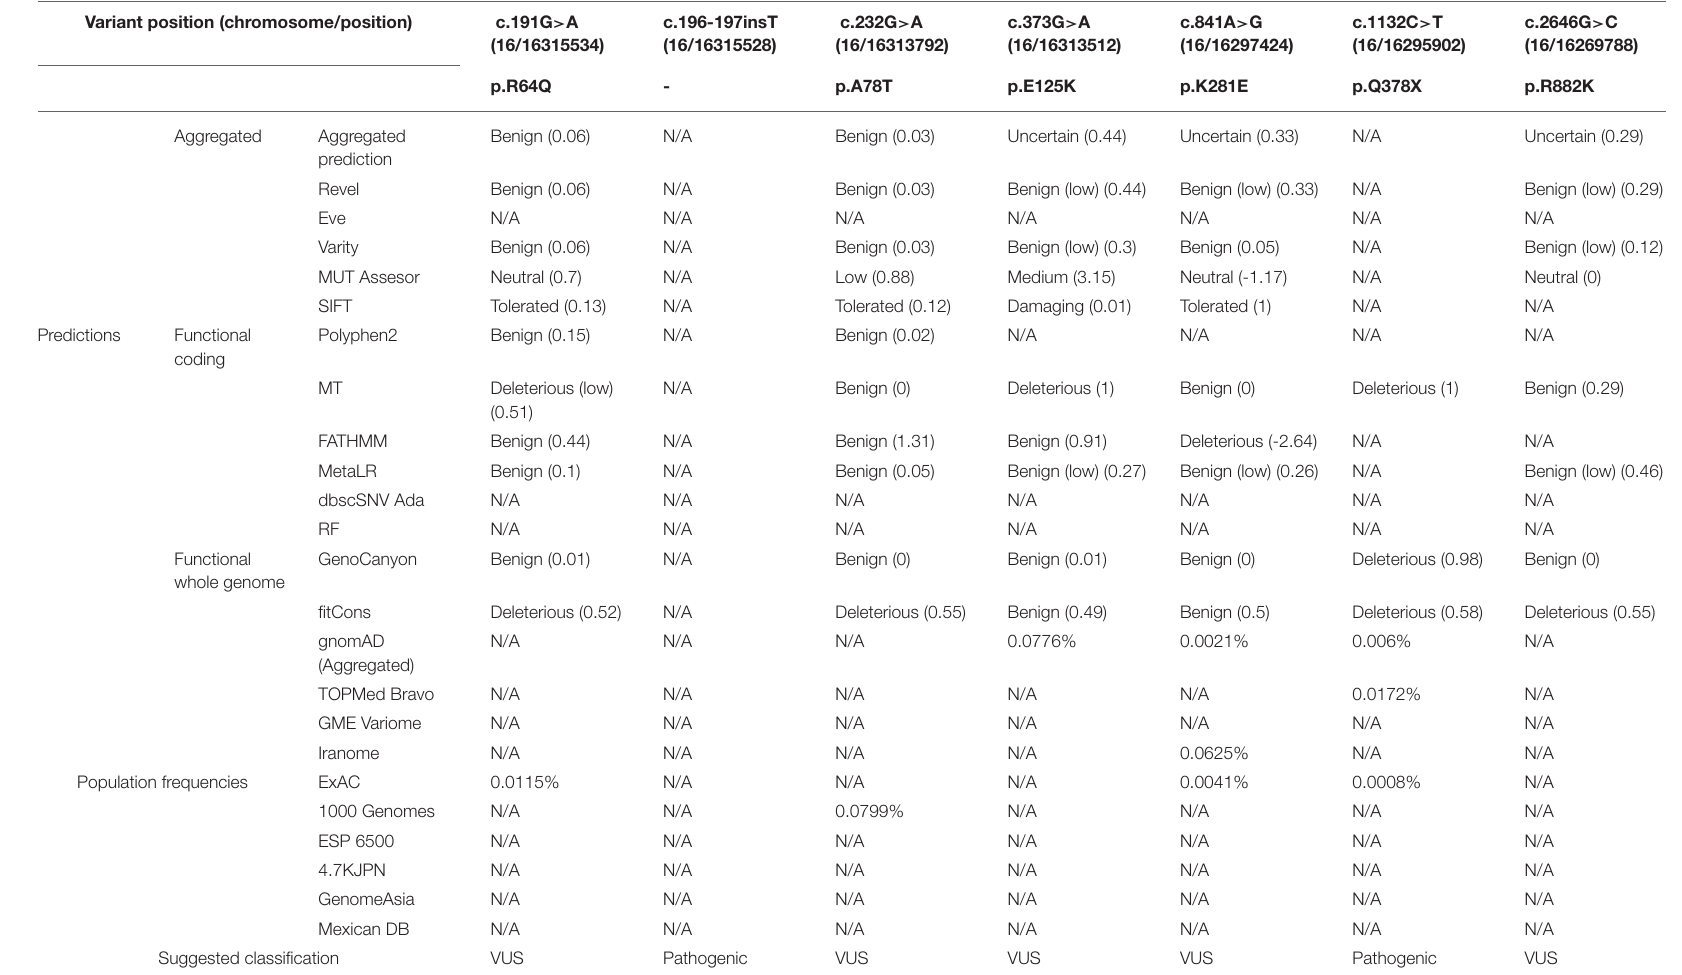
The symbol of “N/A” indicates that there have no data. The row of “Suggested classification” represents the description of pathogenicity of these variants according to the American College of Medical Genetics and Genomics (ACMG) guidelines. “VUS” indicates “uncertain